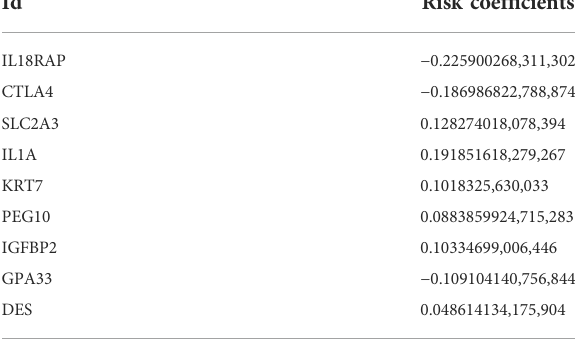
TABLE 1 Risk coef fi cients of nine prognosis related